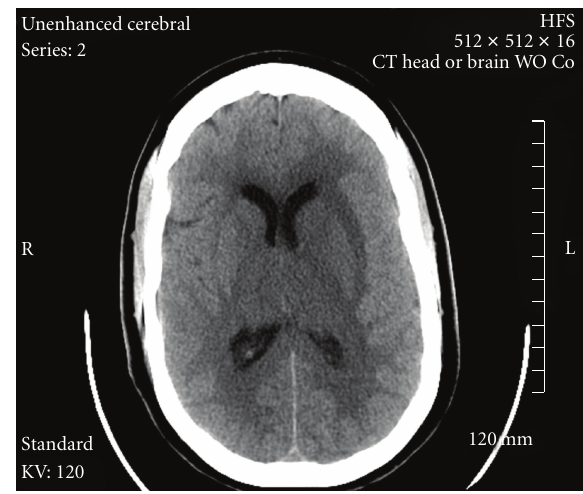
Figure 1: Noncontrast CT scan after 24hours of intravenous Heparin.